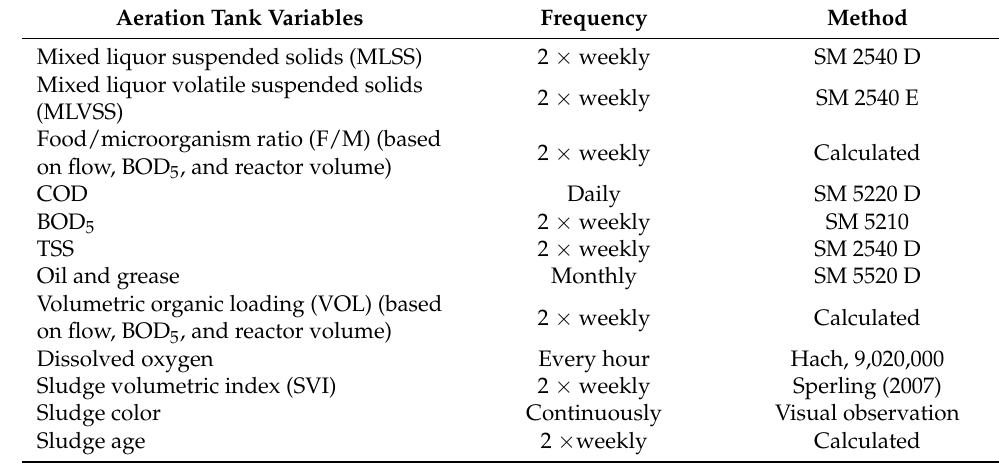
Table 4. Measured and calculated variables in the aeration tank and the